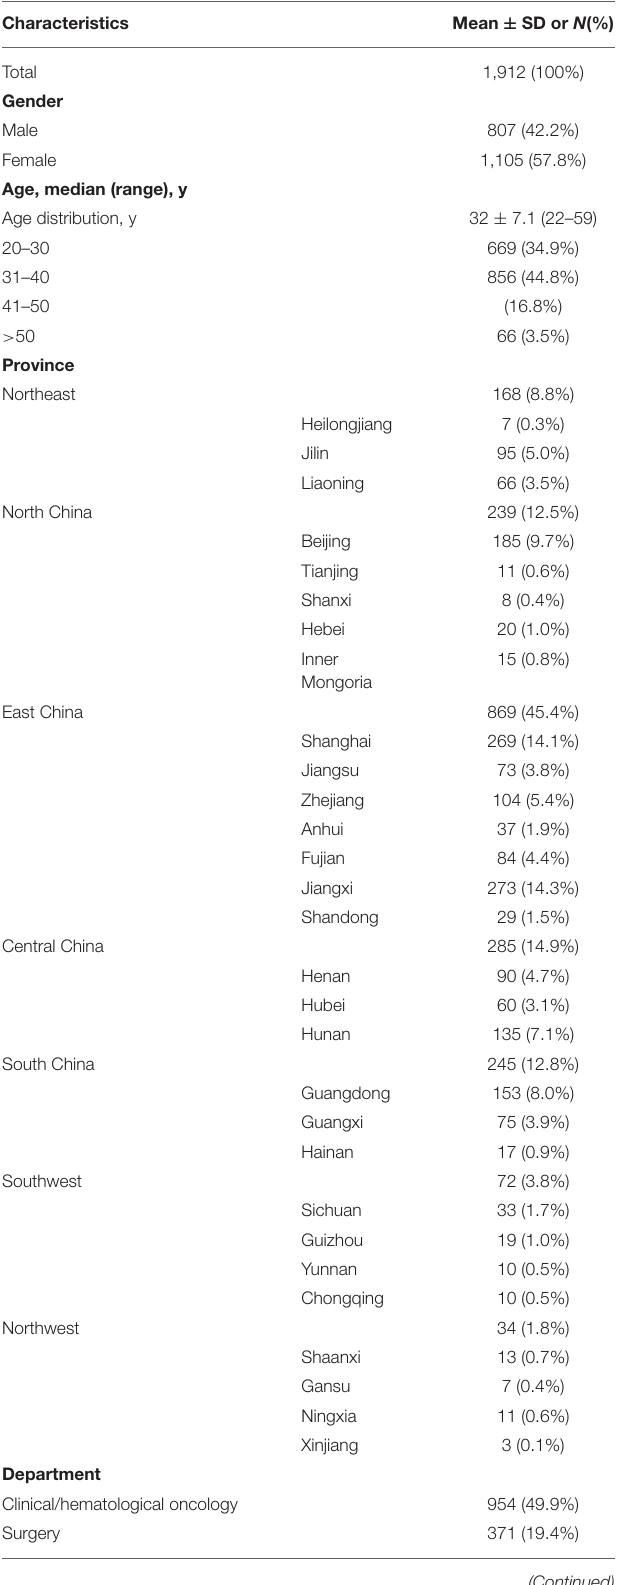
TABLE 1 | Baseline characteristics of healthcare